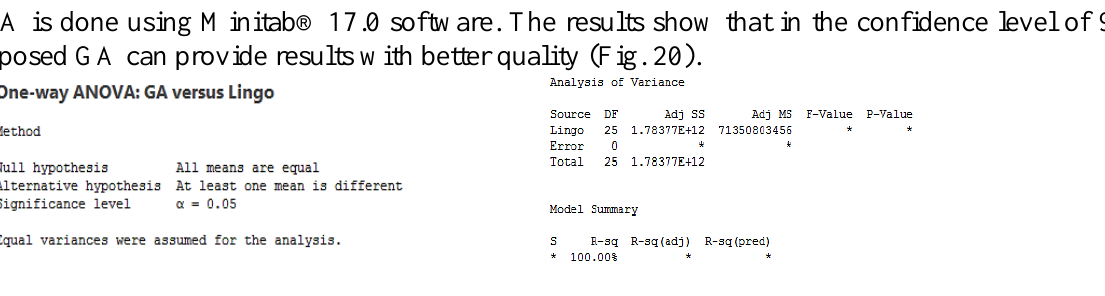
Fig. 20. Results of One way ANOVA for comparing the mean of GA and Lingo 12.0 (α=0.05)